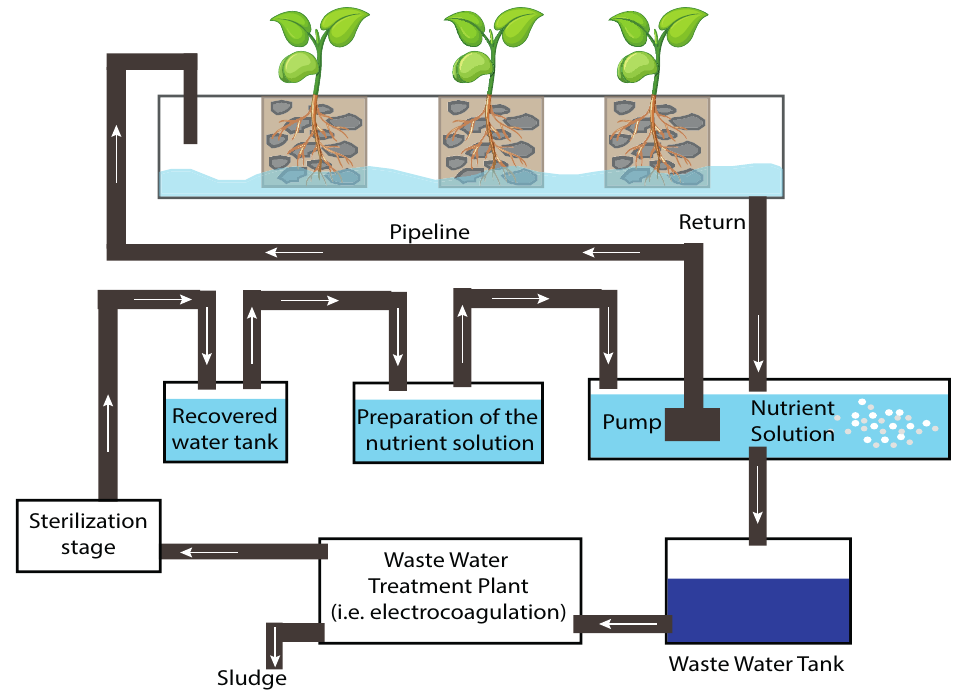
Figure 4. Implementation of a treatment system for water reuse in hydroponics